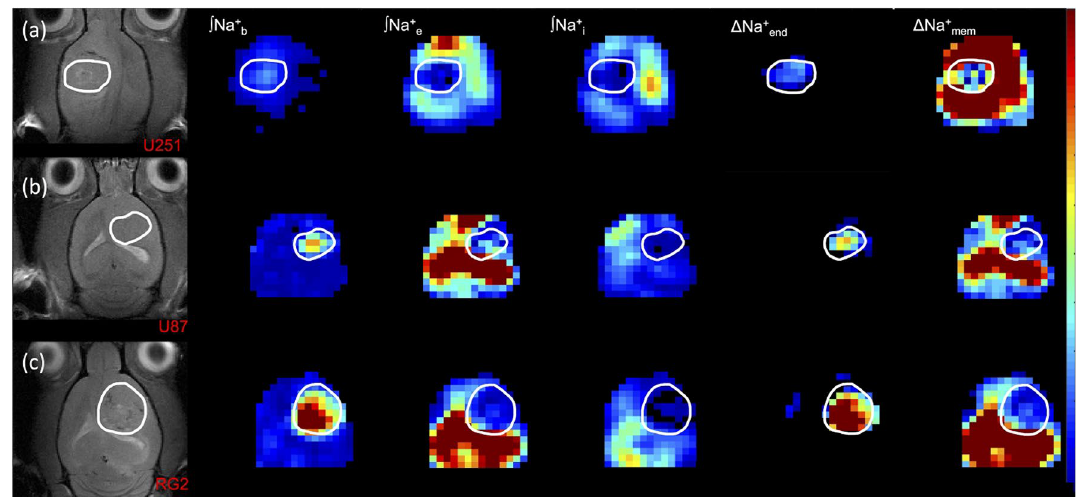
Figure 7. Representative maps of compartmentalized 23 Na signals (Na + b , Na + e , Na + i ) as well as transendothelial (ΔNa + end ) and transmembrane (ΔNa + mem ) gradients in U251, U87, and RG2 tumors. The left column shows the tumor location (white outline) on the anatomical 1 H-MRI for animals bearing ( a ) U251, ( b ) U87 and ( c ) RG2 tumors. The respective three columns show ∫ Na + b , ∫ Na + e , and ∫ Na + i maps. The last two columns on the right show the ΔNa + end and ΔNa + mem maps. In all tumors the ∫ Na + b and ∫ Na + e are high and low, respectively, and thus are the main drivers for a high ΔNa + end and a low ΔNa + mem